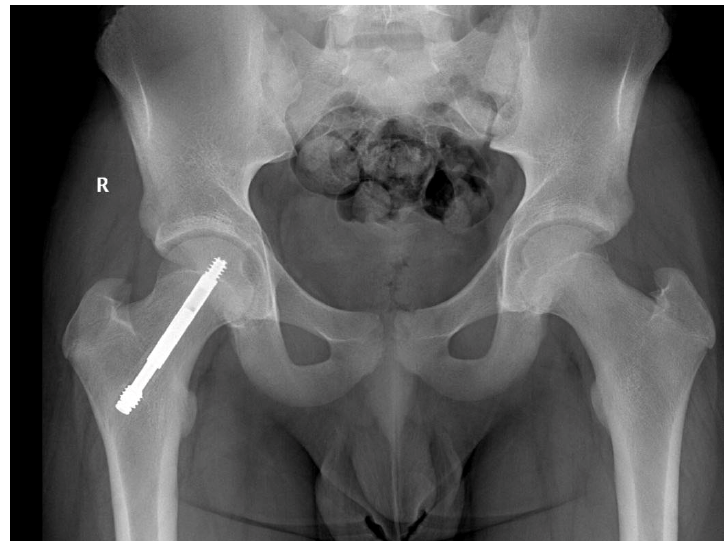
Figure 3. Male patient, 11 years old at time of surgery, screw telescoped at 36 months follow-up; no length discrepancies noted.